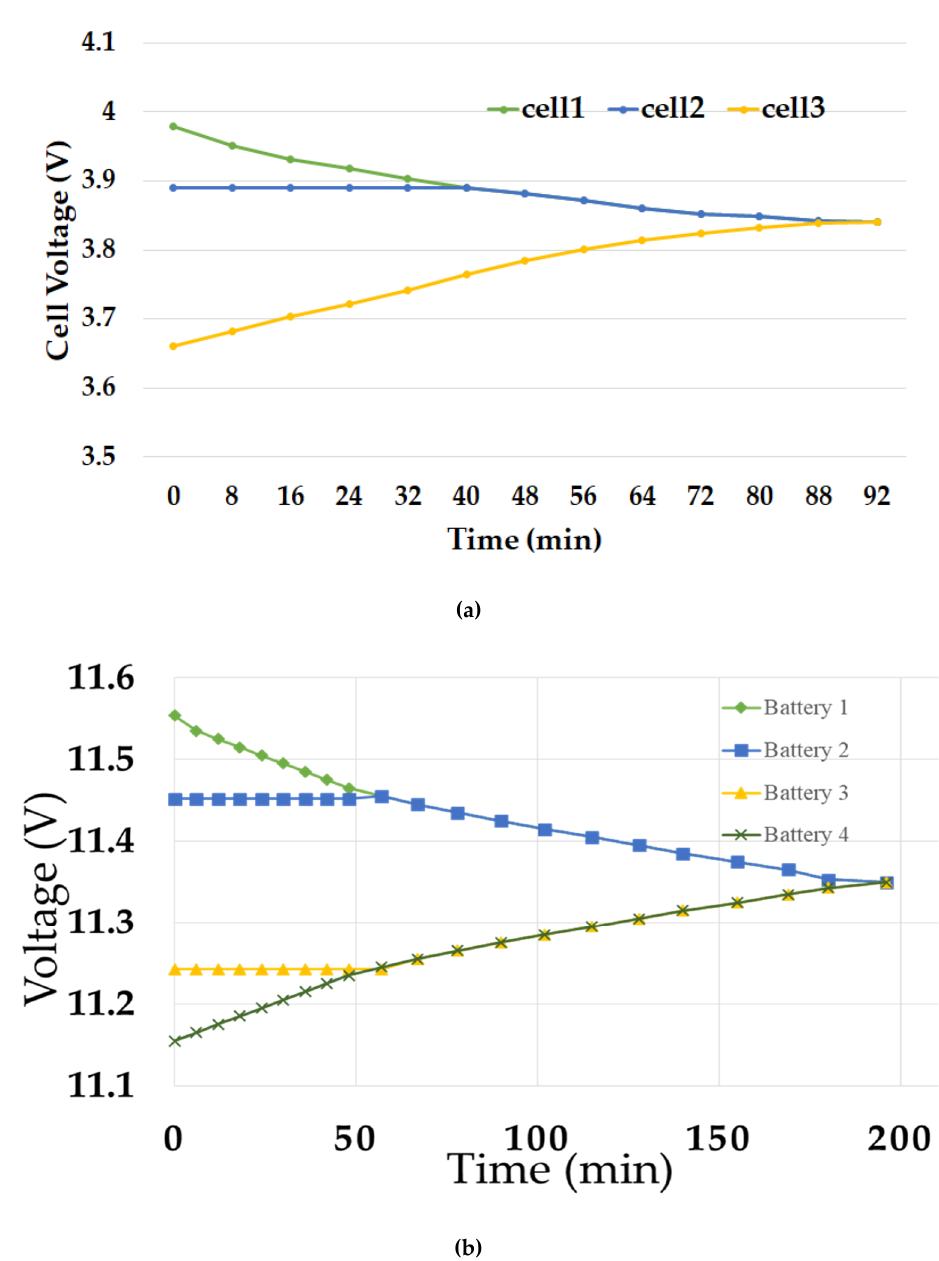
Figure 11. The experimental result, ( a ) measured for three Li-ion battery cells, ( b ) measured for four lead-acid battery cells.